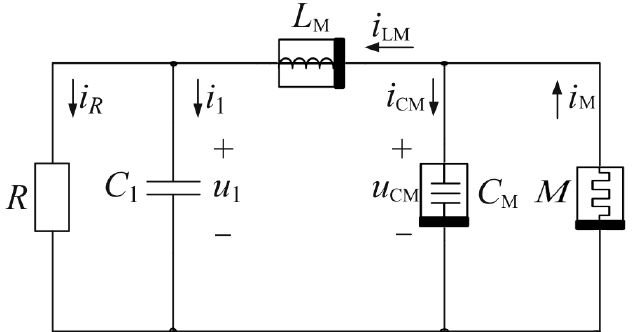
Figure 4. Chaotic oscillator circuit based on three memory